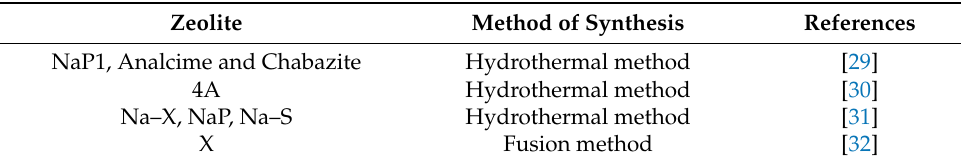
Table 1. Types of materials synthesized from fly ash for Cu(II) removal.